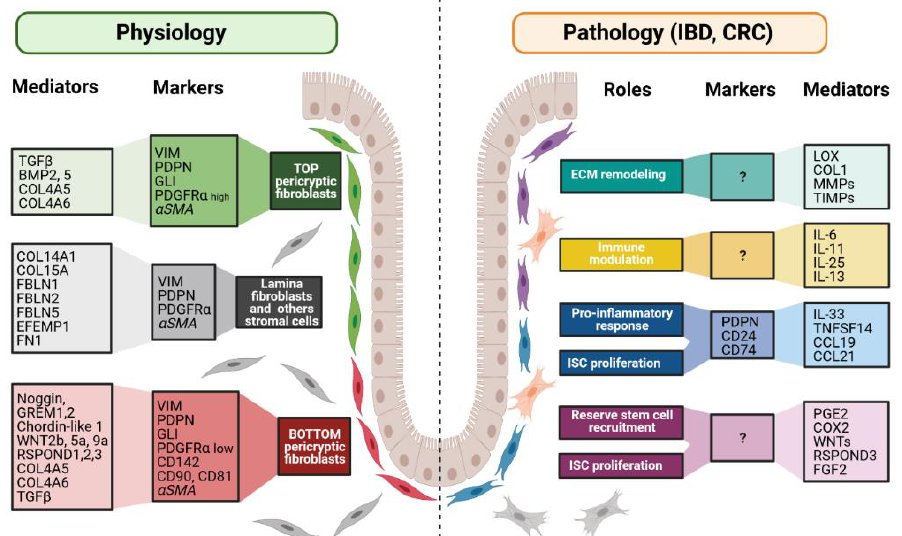
Figure 3. Fibroblast markers and mediators under physiological and pathological contexts. Fibroblasts can be divided into different populations depending on their locations, functions along the crypt axis, and pathophysiological status. More and more studies try to present a panel of markers that can be used to decipher those populations. Although none of them are actually specific of a subpopulation, in combination, they allow the discrimination of the different subpopulations, namely top pericryptic-, bottom pericryptic- and lamina propria-associated fibroblasts. However, discrepancies exist for example concerning alpha smooth muscle actin ( αSMA ), which can be found, or not, on the different populations. Under the pathological context, the discrimination of the diverse fibroblasts populations is increasingly complex, with no markers being currently known to clearly identify the ones implicated in the various pathological processes. Markers and mediators listed in this figure are used as examples and are not exhaustive.